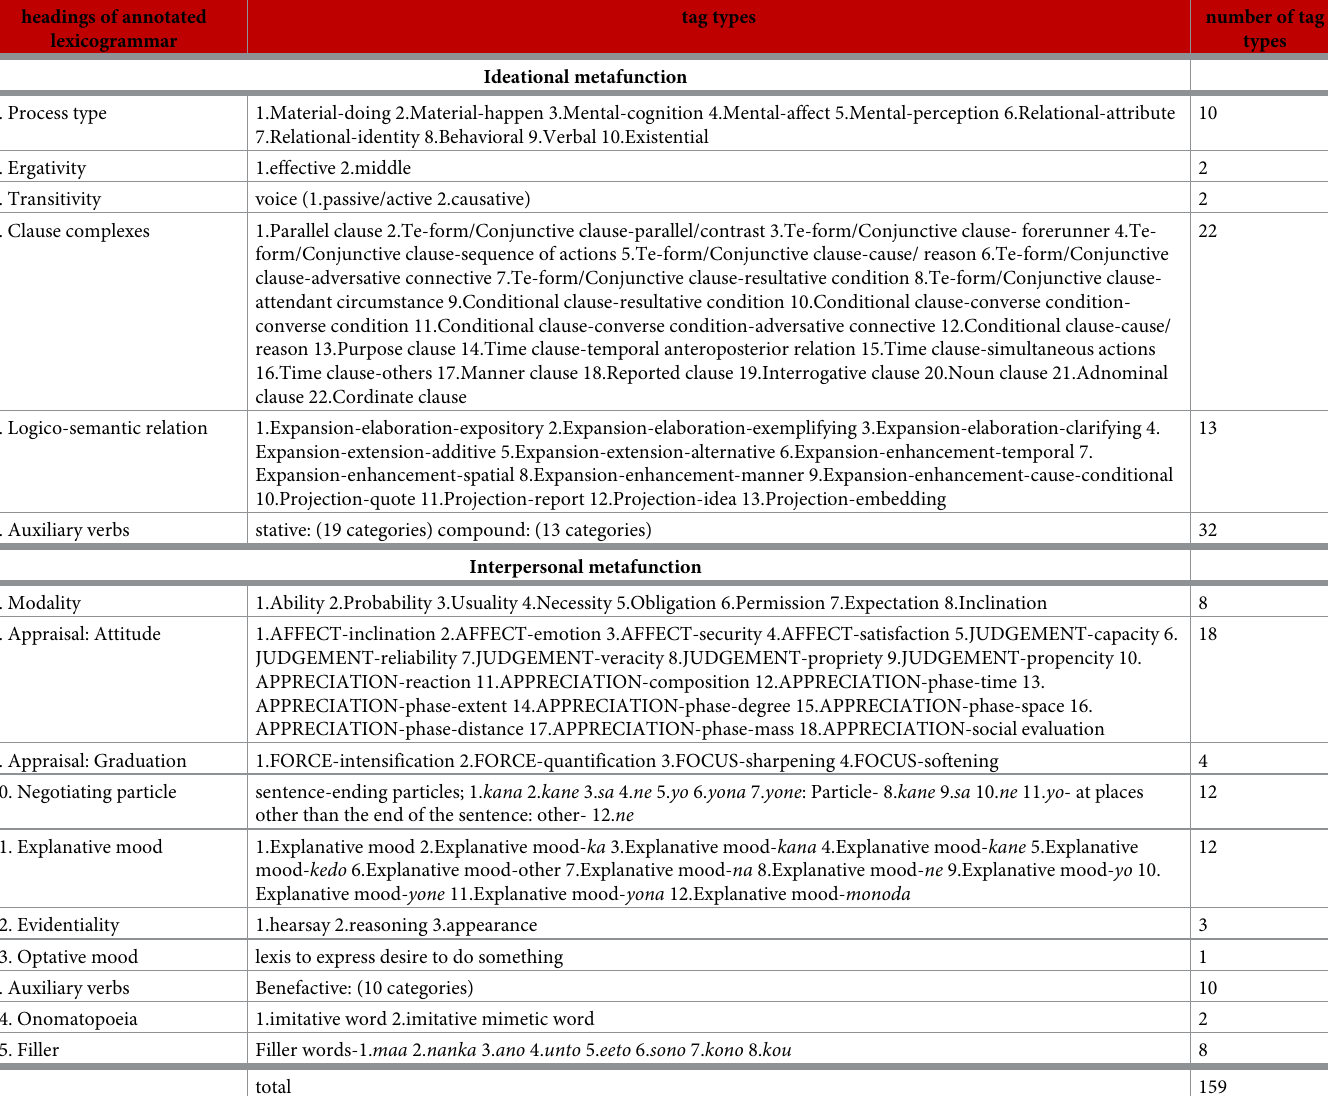
Table 3. Headings of the semantic annotation scheme. headings of annotated